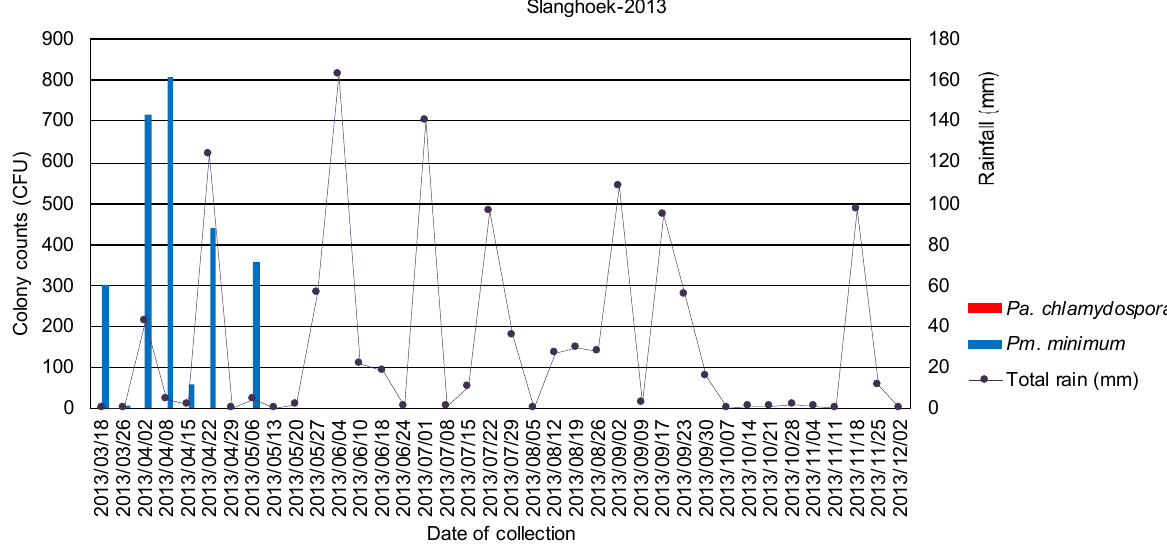
Figure 14. Phaeomoniella and Phaeoacremonium spp. cfu cultured from five vaseline coated microscope slides affixed to each of five root- stock mother vines in a rootstock mother block in Slanghoek, Western Cape province in 2013. The slides were replaced weekly. Each bar represents the total number of cfu cultured on three Petri dishes. Not clear on the graph, the detection date for Pa. chlamydospora is 18/03. The rootstock mother block was removed 13/05/2013 and therefore no sampling occurred beyond this